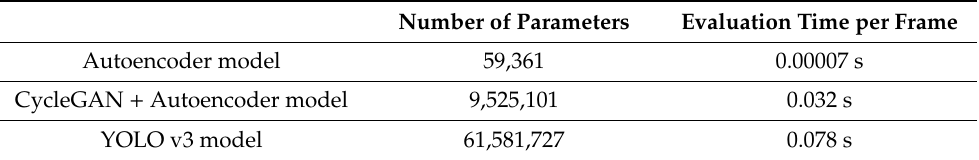
Table 5. The e ffi ciency comparison between the proposed model and reference